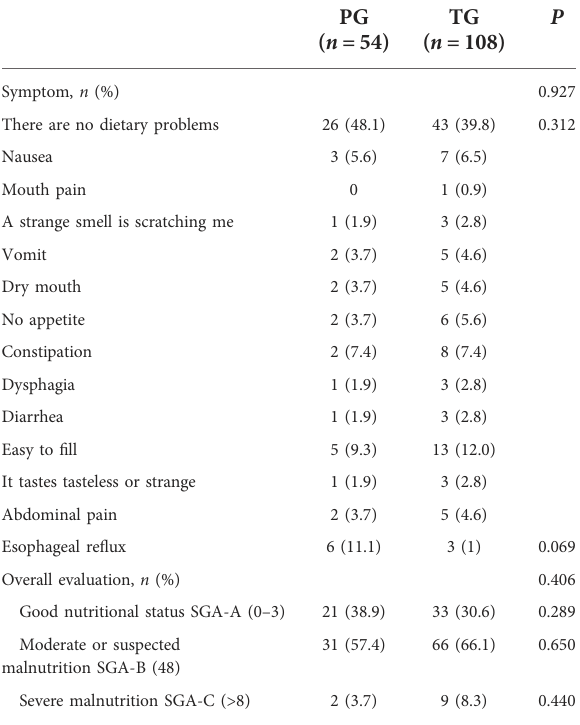
TABLE 5 Comparison of postoperative clinical manifestations and nutritional score by PG-SGA between PG and TG 1 year after surgery.